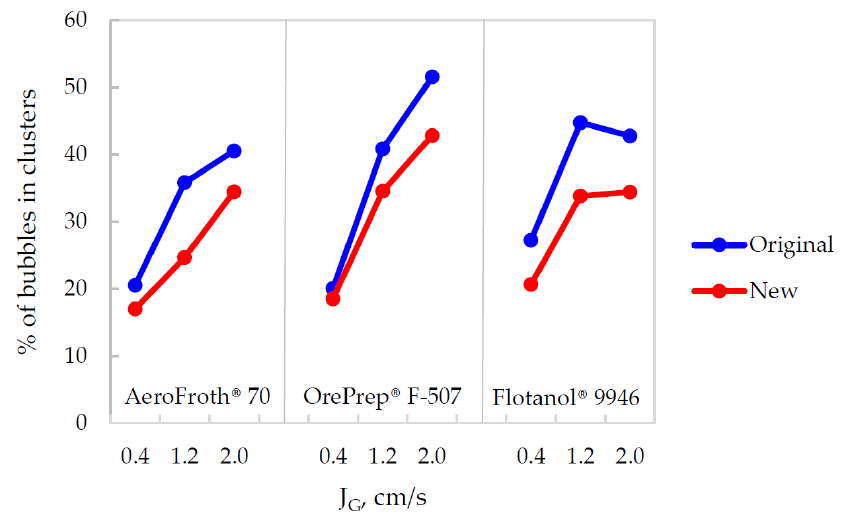
Figure 5. Percentage of bubbles in clusters under the original and new deflectors at a 4 ppm frother concentration.